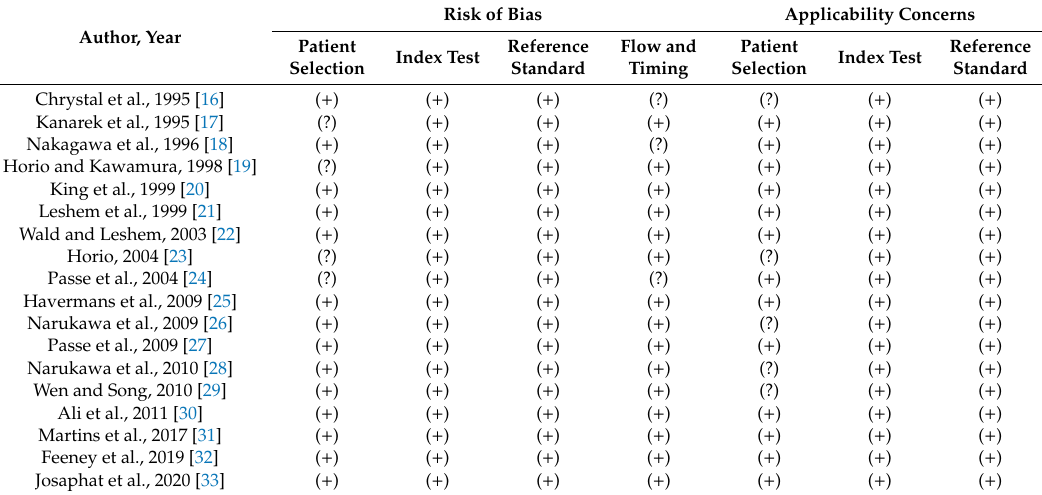
Table 3. Risk of bias assessment.